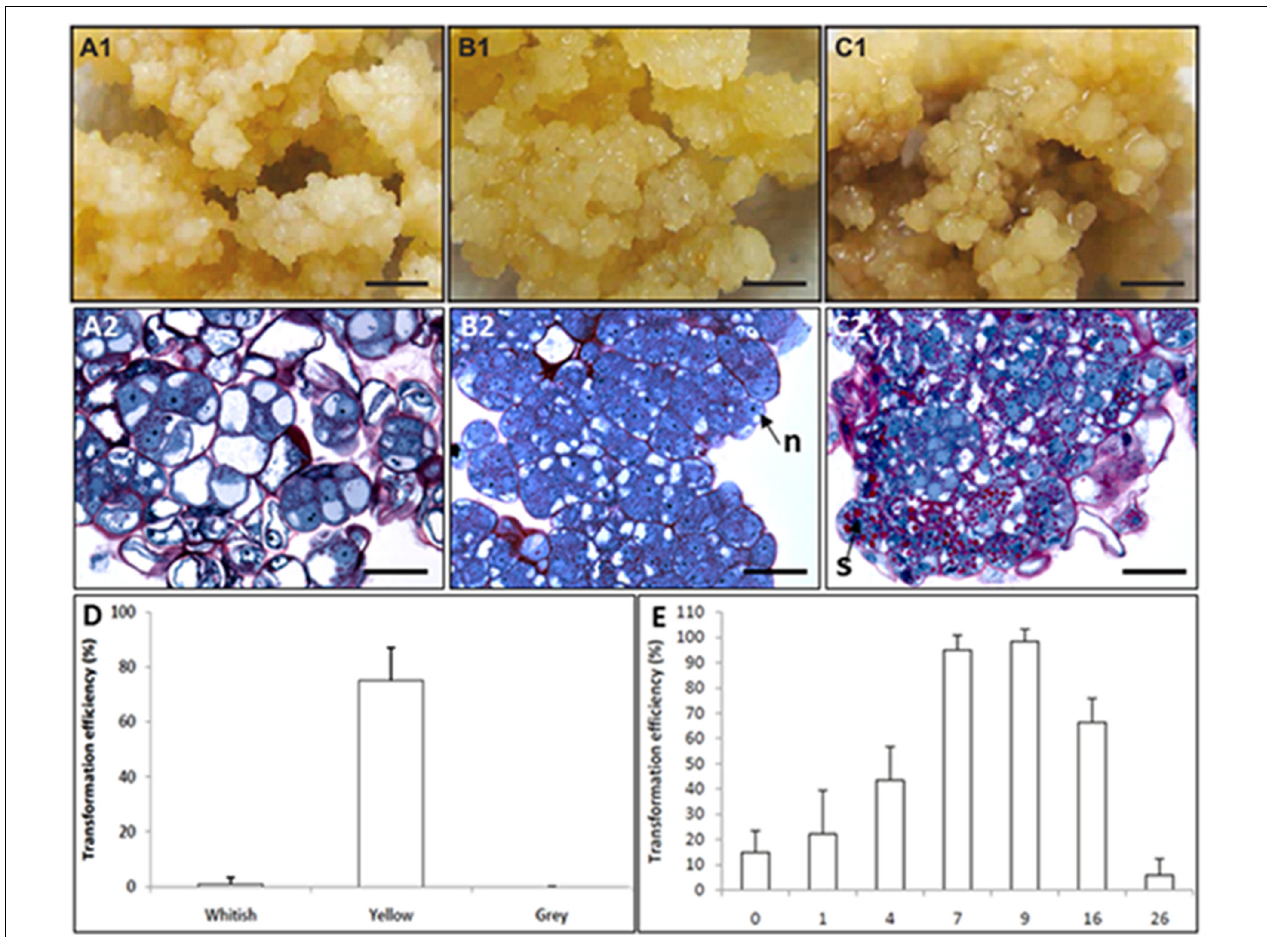
FIGURE 10 | Coffee genetic transformation. Morphological (A1,B1,C1) and histological (A2,B2,C2) aspect of the different callus phenotypes observed in maintained embryogenic cultures assayed for coffee genetic transformation: (A1,A2) whitish type; (B1,B2) yellow type competent for genetic transformation comprising proembryogenic masses (PEMs); (C1,C2) gray type. (D) Transformation efficiency depending on the phenotype of maintained embryogenic callus cultures. (E) Effect of the age of the embryogenic callus culture on A. tumefaciens -mediated transformation efficiency (from Ribas et al.,